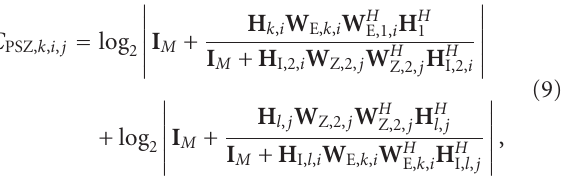
Figure 1: Intercell interference power versus γ I